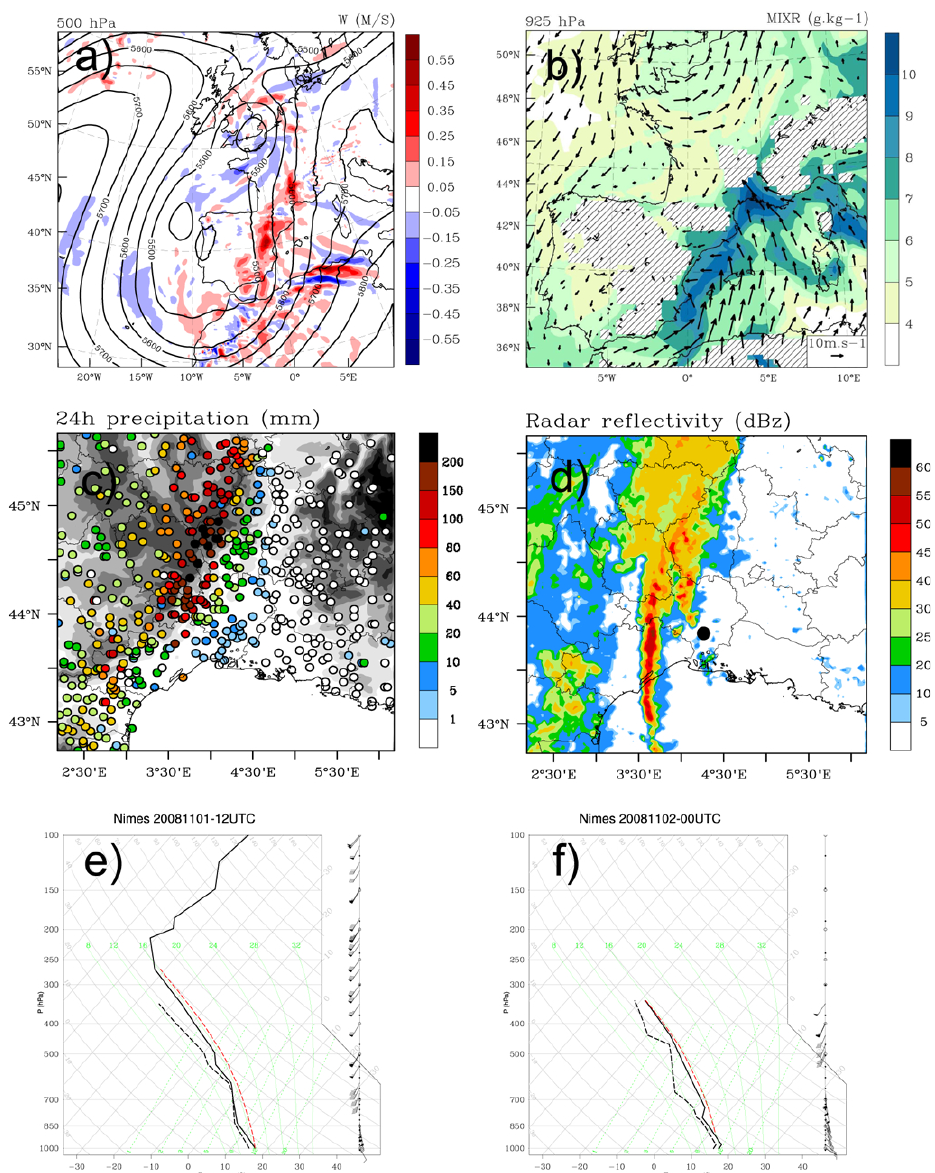
Fig. 3. Overview of the C´evennes case. ECMWF analysis on 00:00UTC, 2 November 2008: (a) 500hPa vertical velocity (ms − 1 ) and geopo- tential height (in m) and (b) 925hPa water vapour mixing ratio and wind. (c) 24-h accumulated rainfall between 12:00UTC, 1 November and 12:00UTC, 2 November (M´et´eo-France rain gauge network) with relief in shading. (d) Radar reflectivity (dBz) from the Nˆımes radar on 2 November 2008 at 00:00UTC. ( e and f ) Nˆımes soundings from 1 November 2008 at 12:00UTC and 2 November 2008 at 00:00UTC,